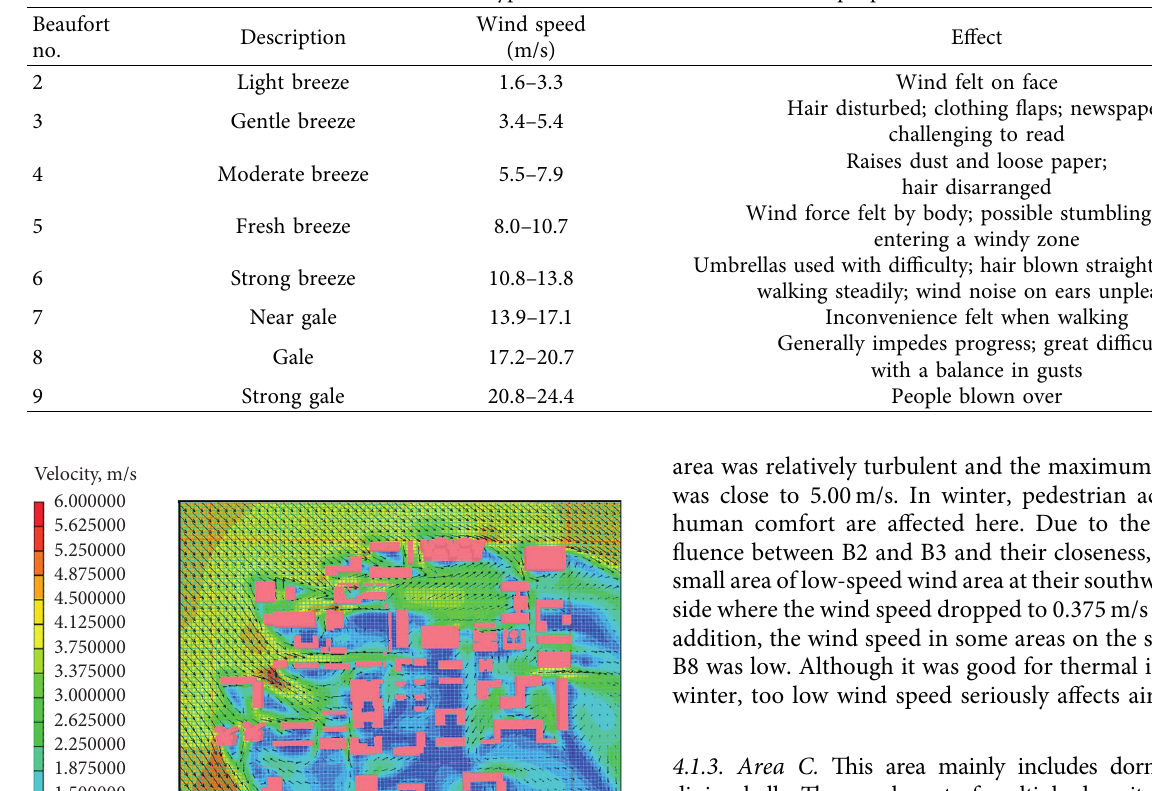
Table 2: Types of wind and effects of wind on people.